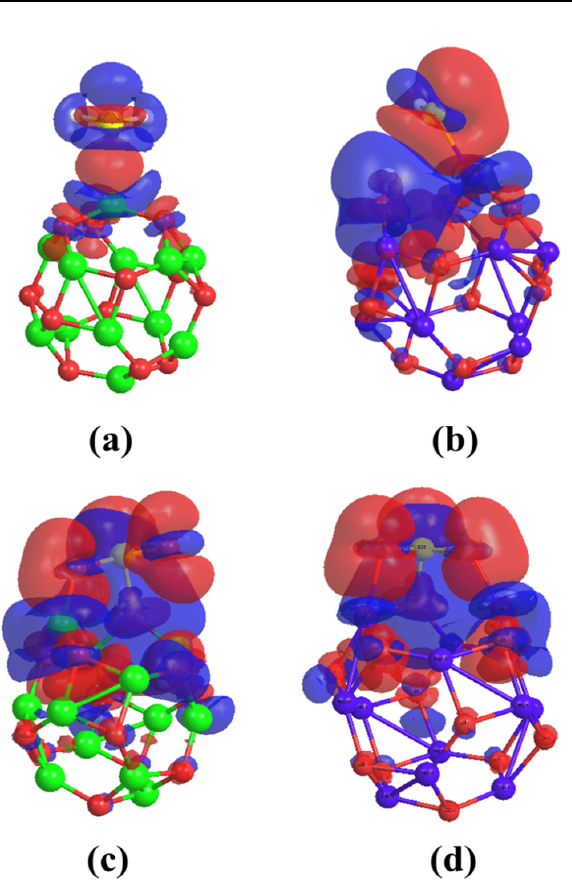
Figure 6. Charge density difference ( Δ𝜌 ) for ( a ) H 2 S/Be 12 O 12 , ( b ) H 2 S/Mg 12 O 12 , ( c ) SO 2 /Be 12 O 12 , and ( d ) SO 2 /Mg 12 O 12 complexes. Red color for negative Δ𝜌 and blue color for positive Δ𝜌 . The H and S atoms of the H 2 S molecule are surrounded by positive Δ𝜌 values (blue color), which confirms the charge transfer from the H 2 S molecule to the nano-cage. In ad- dition, the positive (blue color) and negative (red color) Δ𝜌 values around each of the O2,